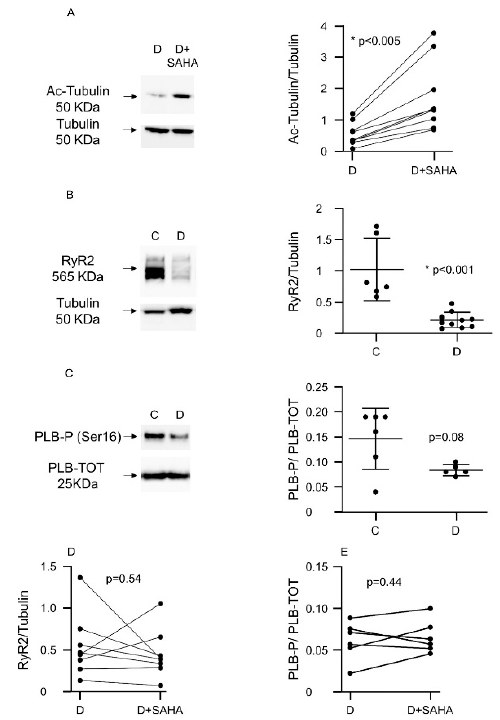
Figure 2. Effect of SAHA treatment on protein expression in left ventricular myocytes. ( A ) Western blot panels and densitometric analysis showing Ac-Tubulin protein expression after SAHA treatment in ventricular CMs isolated from nine D rats. Wilcoxon matched-pairs signed rank test: * p < 0.05 vs. C; ( B ) Western blot panels and densitometric analysis showing RyR2 protein expression reduction in CMs of diabetic rats ( n. of rats = 10) compared to C cells ( n. of rats = 6). Mann–Whitney U-test: * p < 0.001 vs. C; ( C ) Western blot panels and densitometric analysis showing the expression of phosphorylated phospholamban (PLB-P, Ser16) compared to total phospholamban (PLB-TOT), in adult C cardiomyocytes vs. D cells ( n. of C rats = 6; n . of D rats = 5), normalized to total protein concentration (Ponceau). Mann–Whitney U-test: p = 0.08 vs. C; ( D ) Western blot panels and densitometric analysis showing RyR2 protein expression after SAHA treatment in diabetic CMs ( n . of rats = 8). Wilcoxon matched-pairs signed rank test; ( E ) Western blot analysis showing the expression of phosphorylated phospholamban (PLB-P, Ser16) compared to total phospholamban (PLB-TOT) in adult rat CMs after SAHA treatment normalized to total protein concentration (Ponceau) ( n . of rats = 6). Wilcoxon matched-pairs signed rank test.